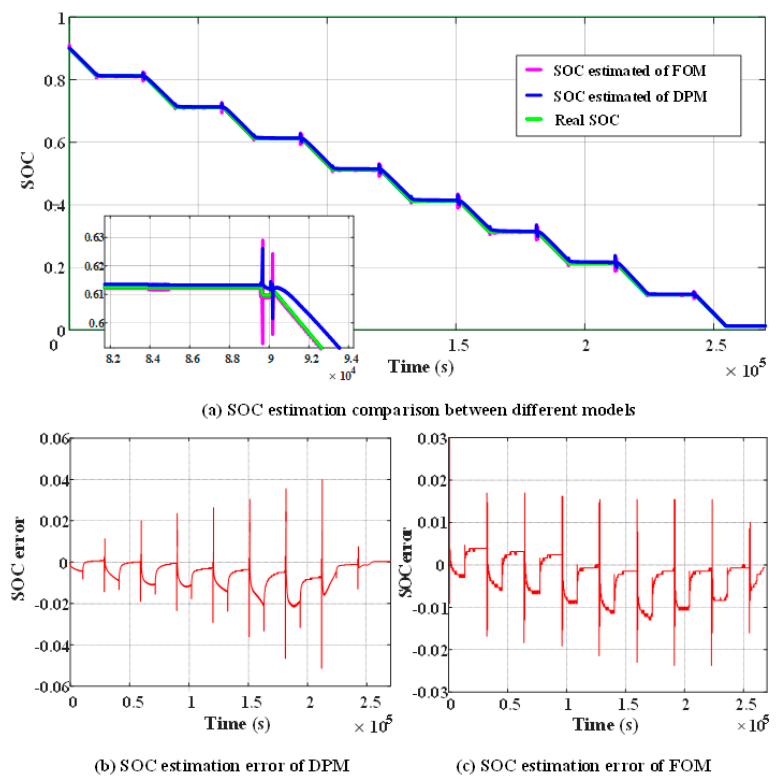
Figure 11. SOC estimation results under the hybrid pulse power characteristic (HPPC) test cycle condition.